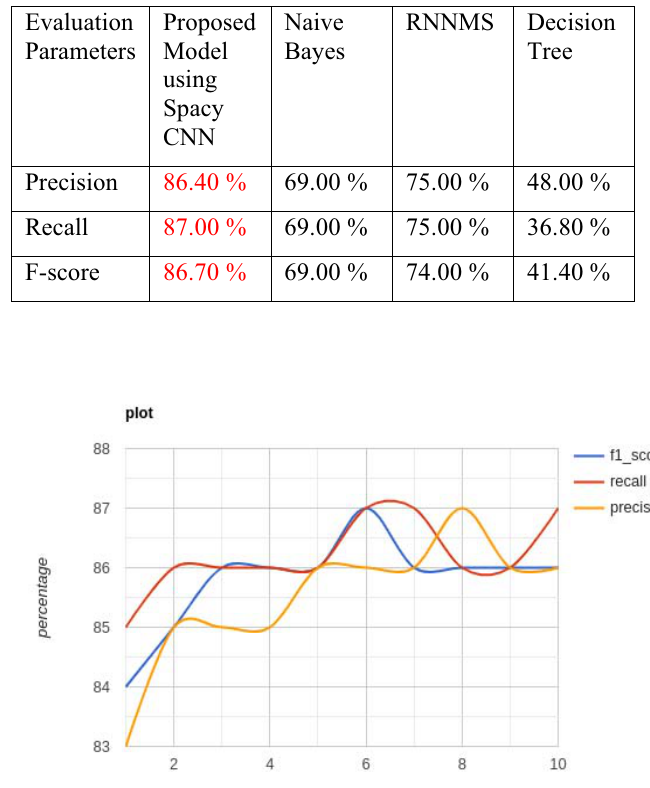
Table 1: Comparison between various models.